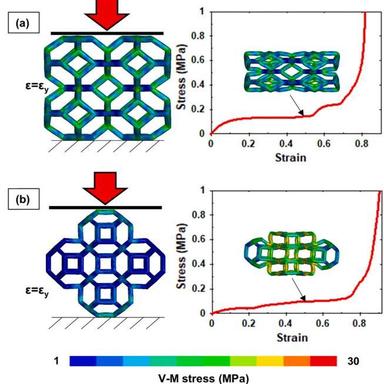
Mechanical responses of kelvin lattice when the loading is applied in different directions with respect to the struts of the cells. a) and b) Bendingdominated behaviour.